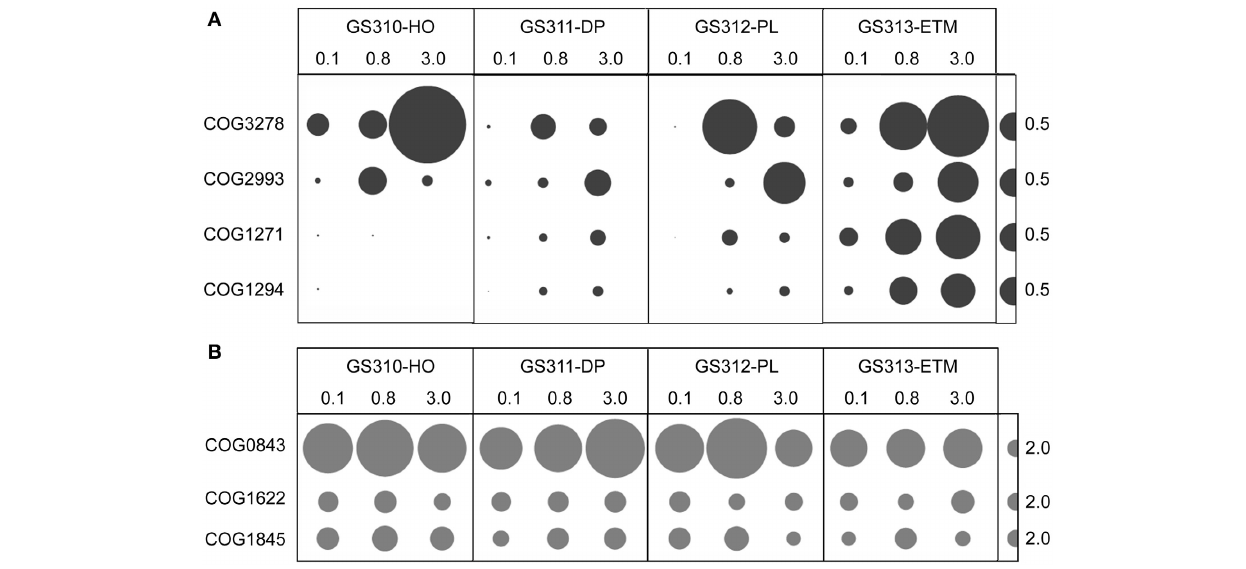
corresponding metagenome. Abundance values are shown by bubble width for each size fraction in each sample. Half-bubbles to the right of each row correspond to 0.5 and 2 genes per average bacterial genome equivalent, in (A,B) , respectively. Sample names above the bubble plots are composed of the GS (“global survey”) number of the JCVI sample database and habitat: HO, hypoxic water; DP, deep ocean bottom; PL, plume; ETM, estuarine turbidity maximum. The numbers above the sample names indicate size fractions: 0.1, 0.1–0.8 μ m; 0.8, 0.8–3 μ m; 3, 3.0–200 μ